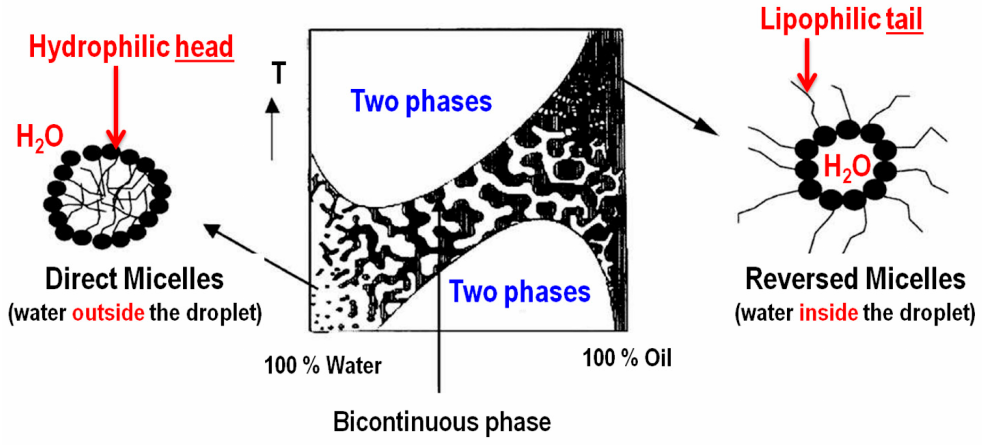
Figure 2. Scheme of the microscopic structure of a microemulsion at a given concentration of surfactant as function of temperature and water concentration, showing the different systems. Reprinted, adapted with permission from Ref. [44]: Copyright 2004, Elsevier and from Ref. [31]: Copyright 1995, American Chemical